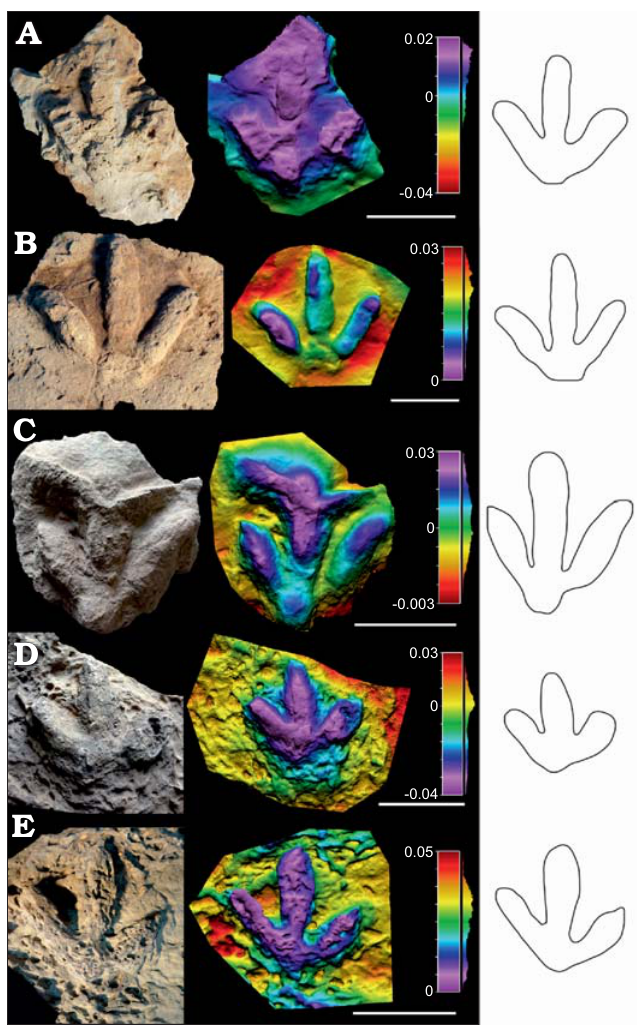
Fig. 3. Photographs, false-colour depth maps, and outline drawing of the tracks of high morphological quality (MP = 2) that belong to the Dinehich- nus isp. morphotype. Portugal, Alcobaça Formation, Kimmeridgian–lower Tithonian (A, B, ?D, E) and Freixial Formation, middle–upper Tithonian (C). A . SHN.(JJS).ICNO.58, Serra do Bouro. B . SHN.(JJS).ICNO.60, Boavista do Bouro. C . SHN.(JJS).ICNO.68, Pedra da Ulsa. D . SHN.(JJS). ICNO.109, Salir do Porto. E . SHN.(JJS).ICNO.113, Serra do Bouro. Scale bars: A, B, 10 cm; C–E, 15